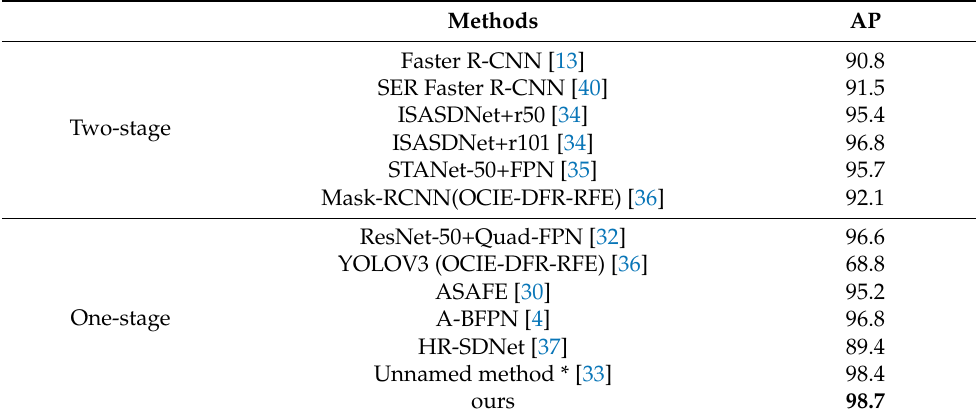
Table 3. Comparison with the latest SAR ship detection methods on